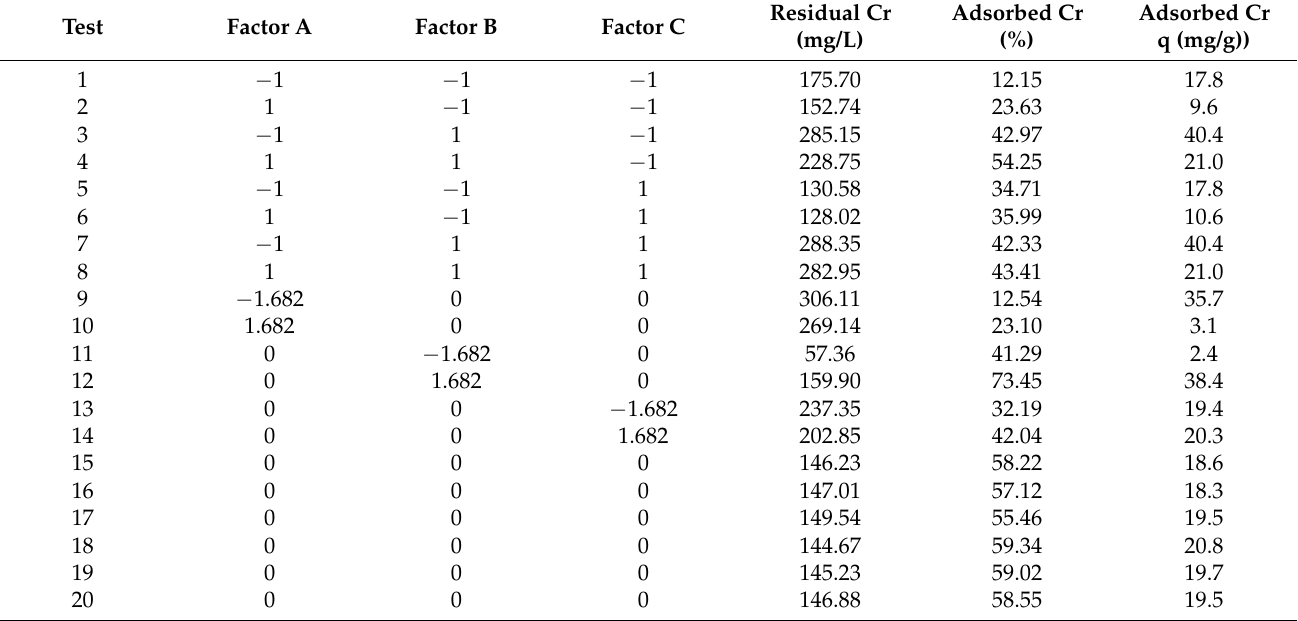
Table 4. Results of the adsorption of Cr(VI) in spirulina biomass using a central composite